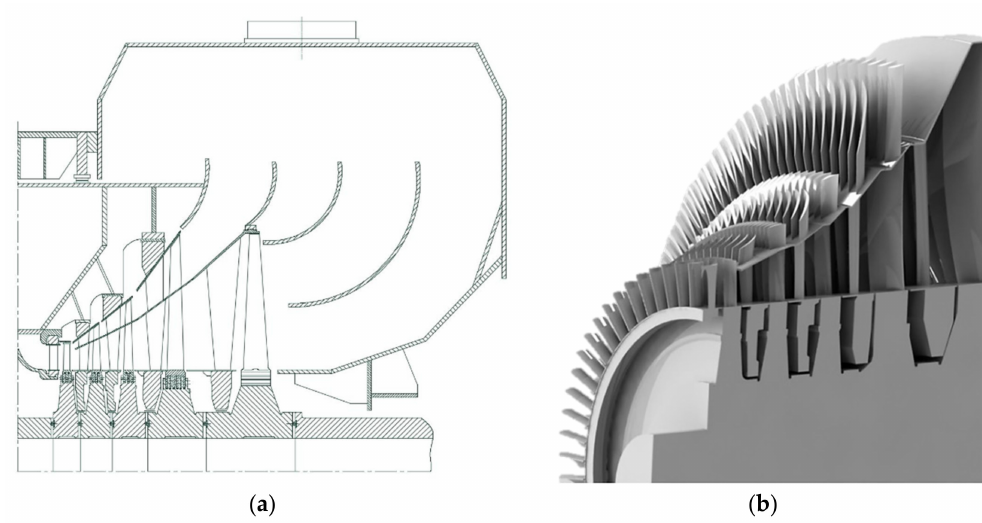
Figure 9. The two-tier LPT: ( a ) Axial cross-section; ( b ) 3D model. The two-tier blades are at the base of the two-tier flow path. It is reasonable to design the first two blades with equal blade numbers in the top and lower tiers. The last two-tier stage has different numbers of blades in the tiers. This design has a higher aerodynamic efficiency caused by lower fan factor losses. This technical solution corresponds with the “fork” blade shown in Figure 10.